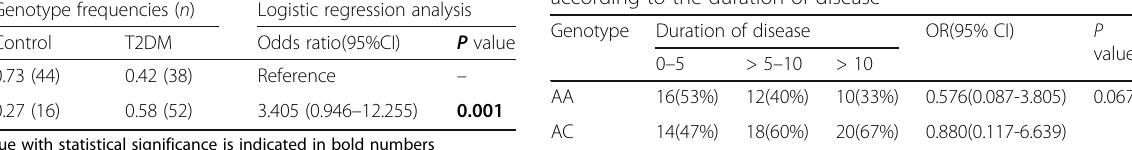
BMP15 genotype for